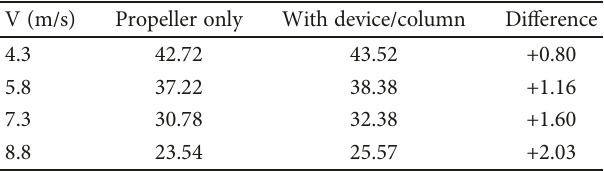
Table 7: Comparison of thrust. V (m/s)